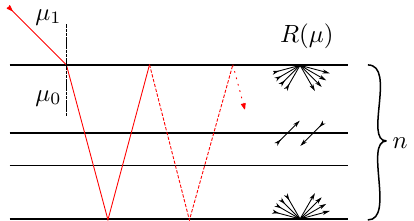
Figure 1. Schematic of the problem geometry. A stack of three laterally infinite layers is illuminated by a collimated beam with angle cosines of µ 1 and µ 0 outside and inside of the stack, respectively. On the top and bottom surface, Fresnel reflections must be accounted for, while the radiance is continuous at the layer